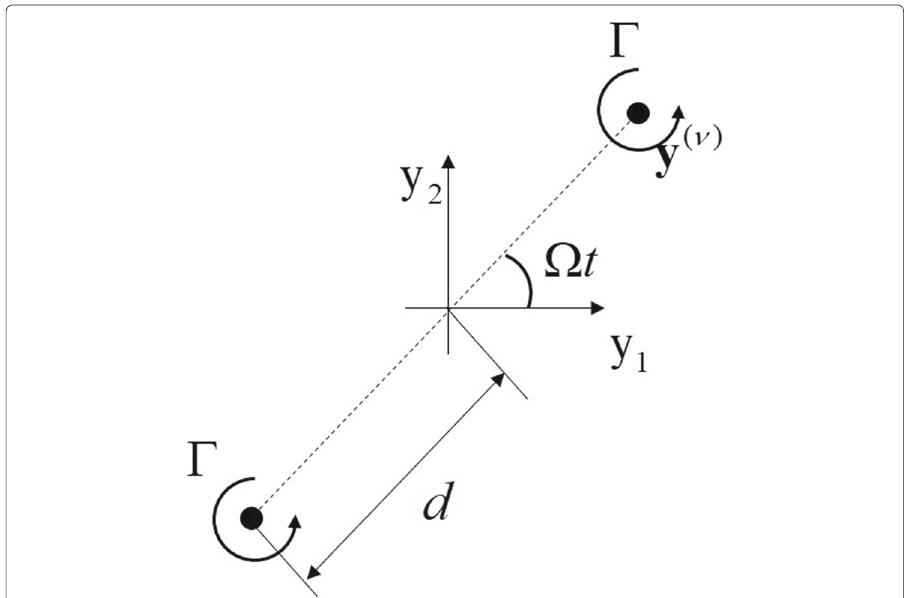
Fig. 9 Schematics of a co-rotating vortex